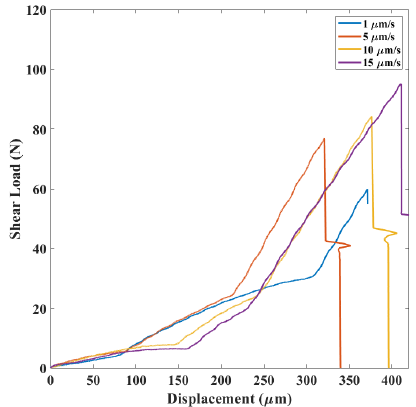
Figure 9. Load-displacement results in category C.